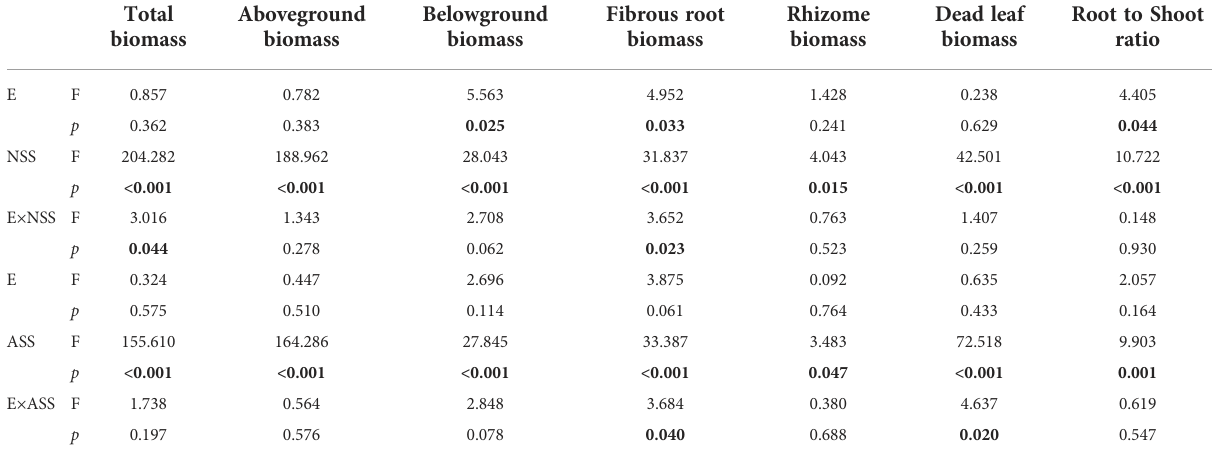
TABLE 3 ANOVA results for the effect of endophyte status and salt stress on biomass allocation of L. chinensis . Total Aboveground biomass